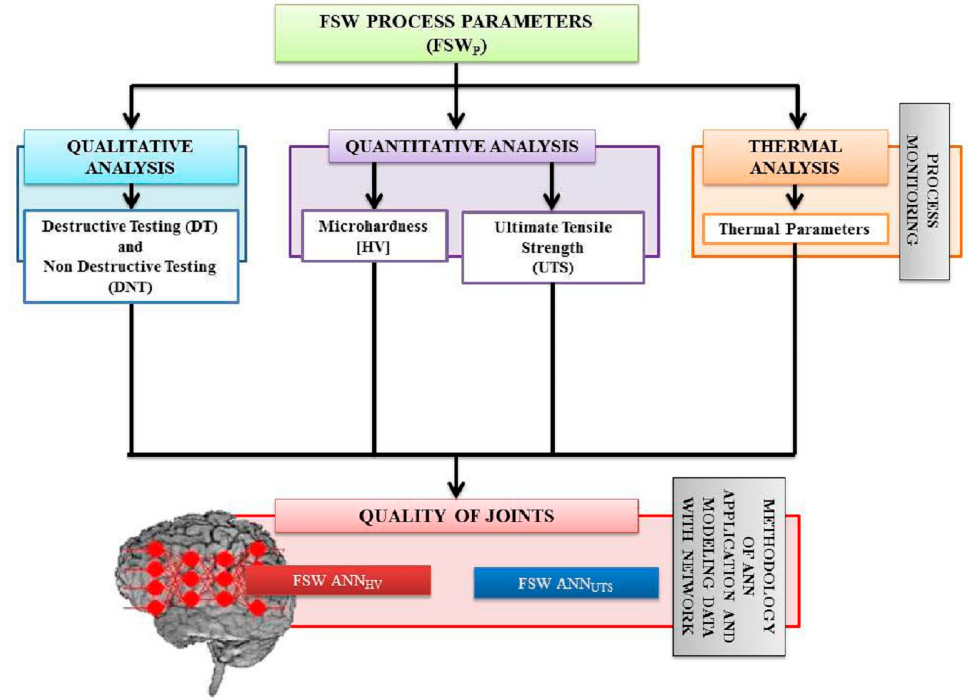
Figure 2. Approaches used for evaluating the quality of FSW process through destructive and non-destructive